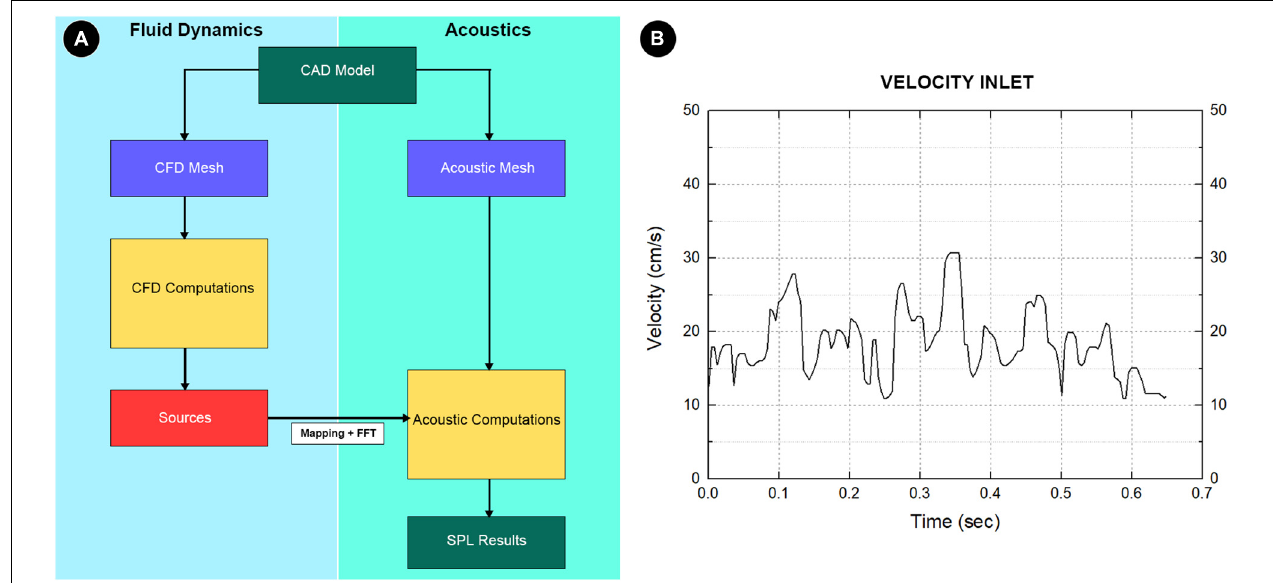
FIGURE 4 | (A) The complete workflow of computational fluid dynamics (CFD) simulation. First, the pressure, density, and velocity fields output by the CFD solver was read. Second, the contributions according to the finite element method formulation were implemented in Actran software. Third, the contributions were projected on the acoustic mesh. Fourth, the corresponding data were stored and displayed in the Actran software. Fifth, the quantities from the time to the frequency domain were transformed using the Fourier transform algorithm. (B) Boundary condition at the inlet section.